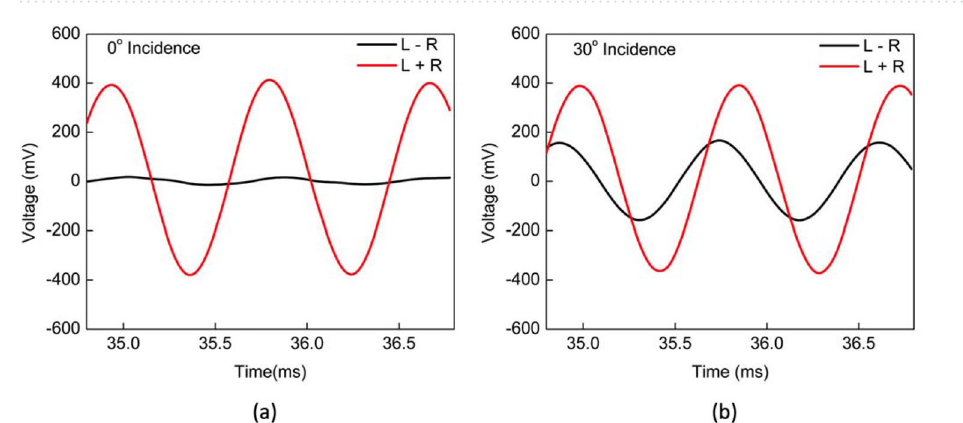
Figure 8. Recorded wings’ waveforms. Voltage signal associated with each wing, left (L, blue) and right (R, red), were stored each in one channel of an oscilloscope with the sensor under single tone (1150 Hz) sound excitation. The angle of incidence on the sensor was adjusted with the turntable for two distinct values: ( a ) normal incidence (0°); ( b ) incidence at 30°.